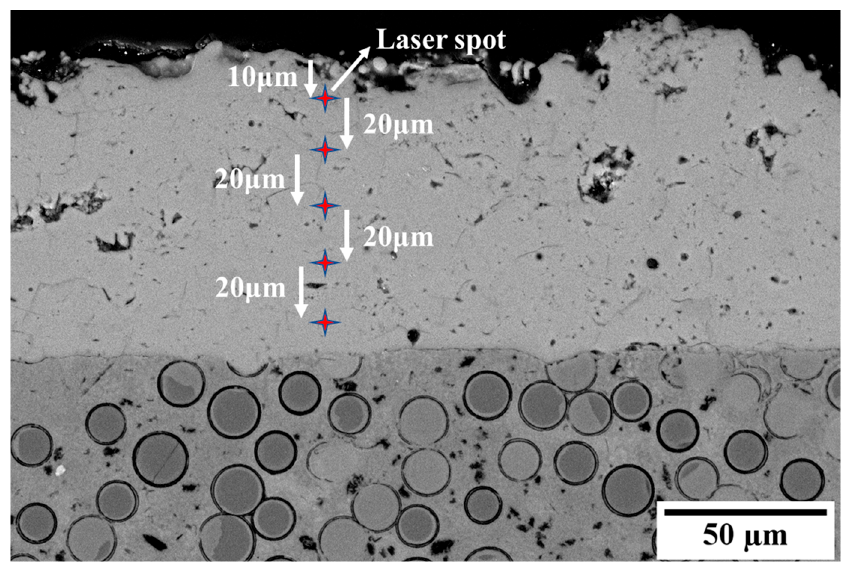
Figure 12. BSE-SEM image of the as-sprayed silicon layer and schematic diagram showing the positions measured using Raman spectroscopy.